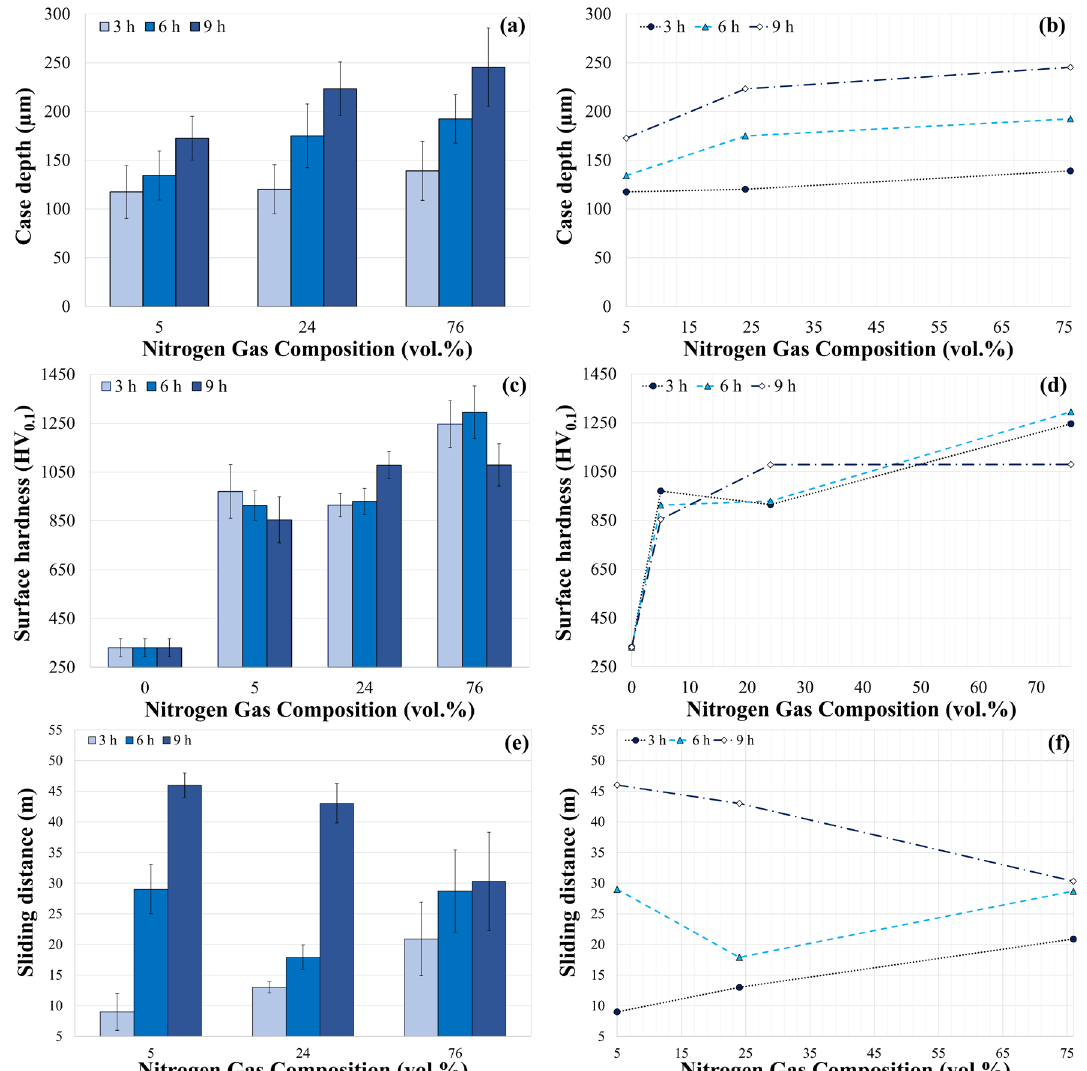
Figure 12. Interaction plot nitrogen gas composition and nitriding time with: (a, b) Case depth; (c, d) Surface hardness; (e, f) Sliding distance before microcracks formation or delamination of the surface